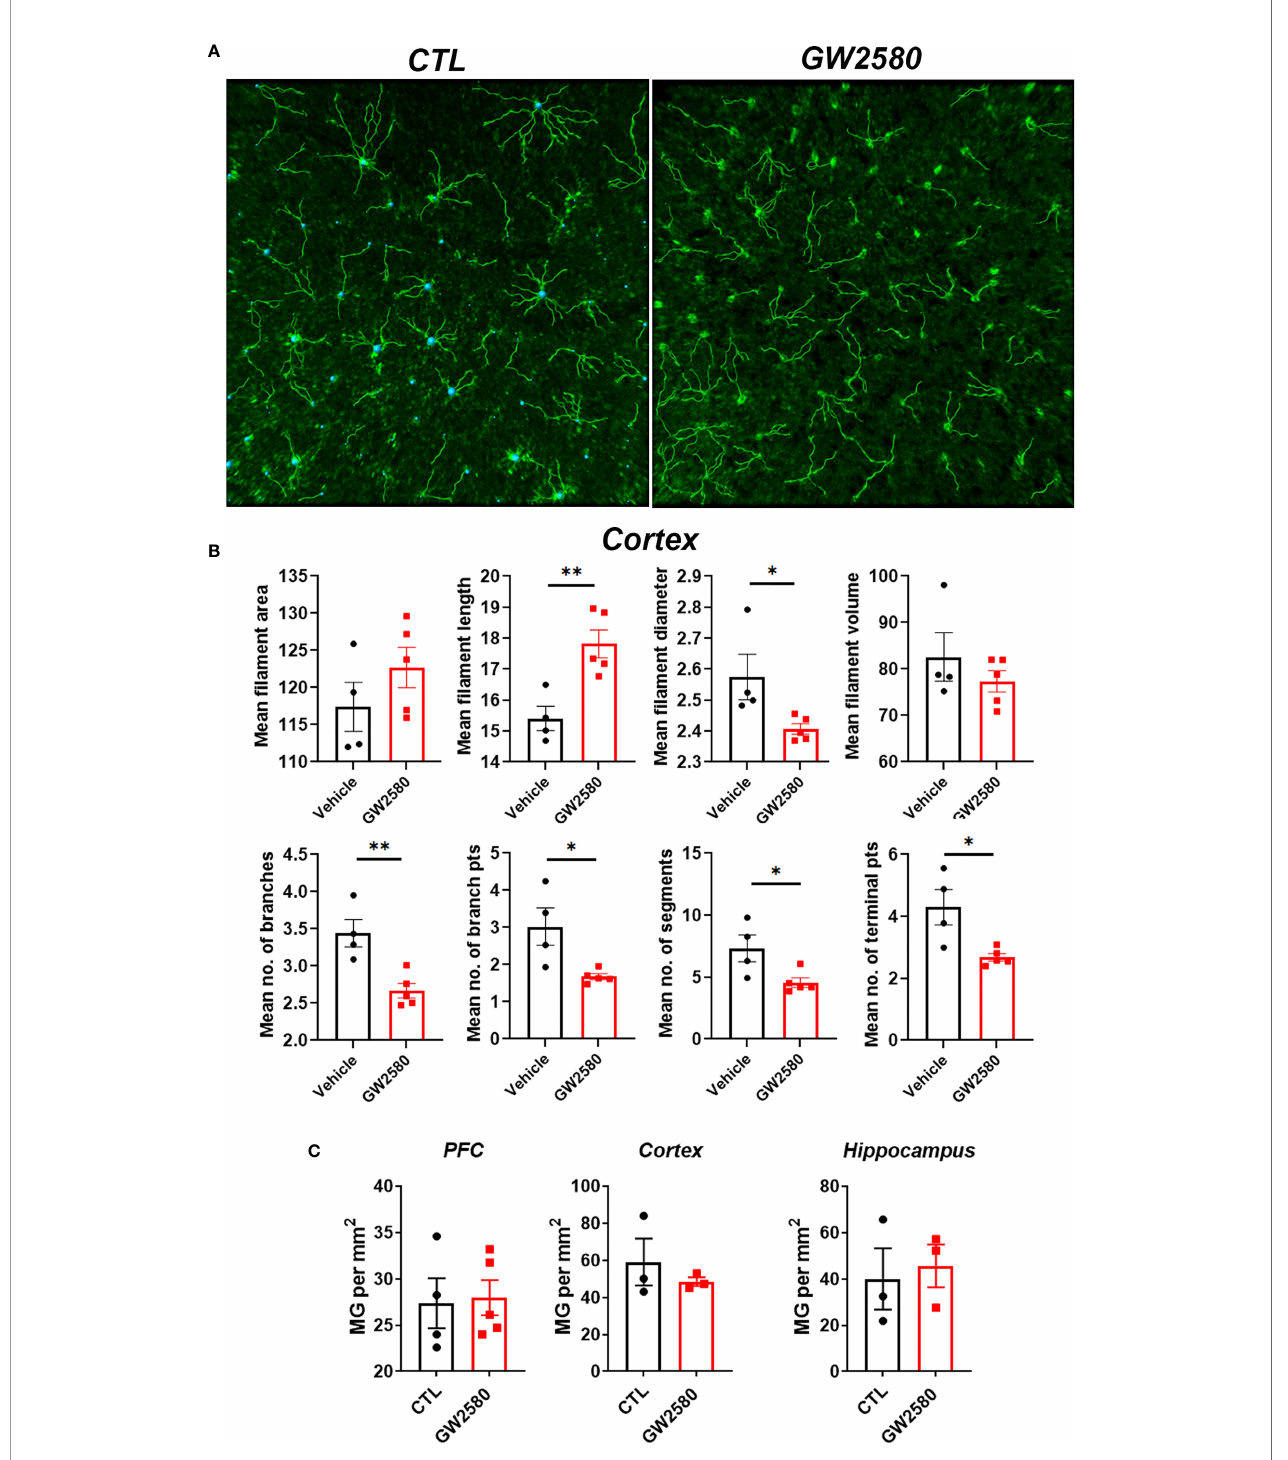
FIGURE 3 | Effect of GW2580 treatment on changes to microglia morphology. (A – C) Mice were treated with GW2580 by oral gavage for 8 days and the effect of treatment on microglia morphology and viability examined. (A) Representative three dimensional reconstruction of a microglia cell in the cortex of vehicle and GW2580 treated mice from a 20x picture. Scale bar is 50 m m. (B) Results from Imaris analysis. Each point represents an average of three cells per mouse (n=4-5 animals per group), average of three 20x z-stacks of 25µm and 500nm steps per animal. (C) Microglia counts per mm 2 in the prefrontal cortex, cortex and hippocampus. Each point represents an average of three pictures. Data shown are expressed as means ± standard error (SE). Statistical signi fi cance is represented by p-value < 0.05 (*), and p-value < 0.01